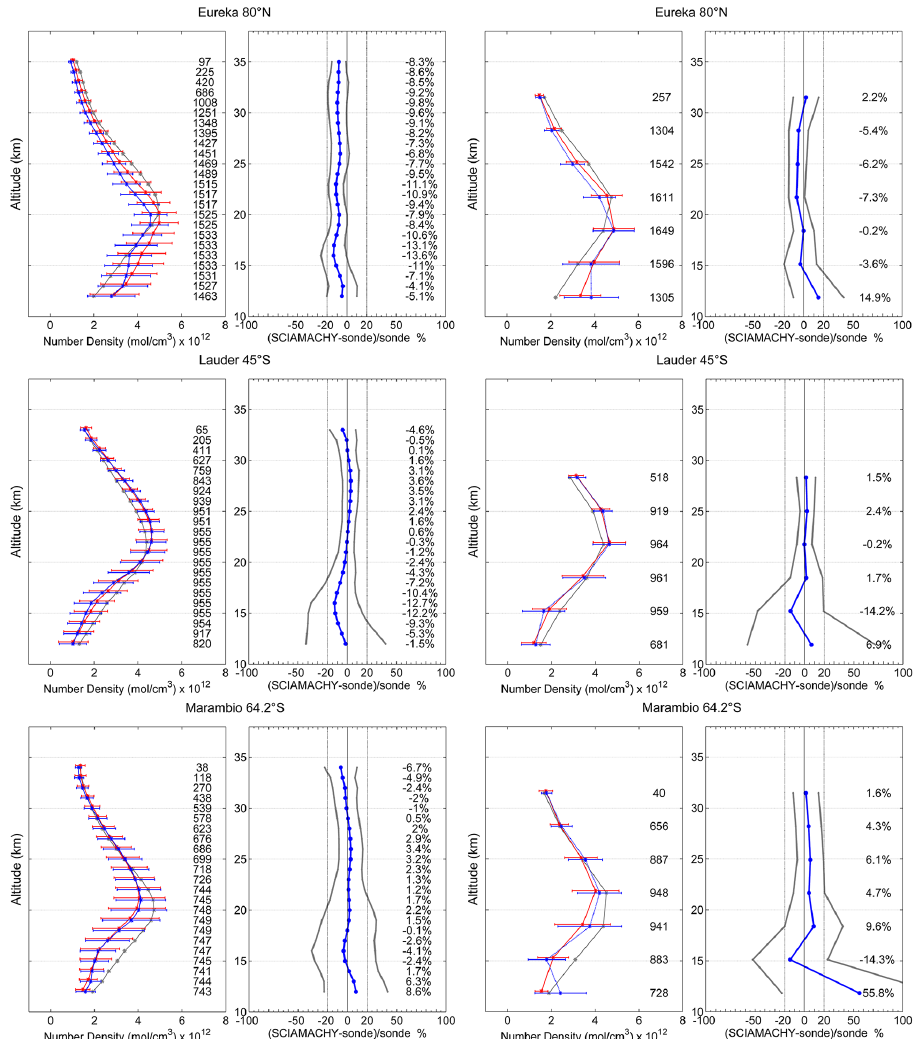
Figure 2. Vertical profile comparisons at Nairobi (1.2 ◦ N, 36.8 ◦ E), Ankara (40.0 ◦ N, 32.8 ◦ E), Praha (50.0 ◦ N, 14.4 ◦ E), Eureka (80.0 ◦ N, 85.9 ◦ W), Lauder (44.9 ◦ S, 169.7 ◦ E) and Marambio (64.2 ◦ S, 56.6 ◦ W) averaged from January 2003 to December 2012. The four panels show the results for the ozone profiles for V2.9 on the left-hand side and for V3.0 on the right-hand side. In the left subpanels, the red and blue curves represent the ozone number densities with 1 σ standard deviations for ozonesonde and SCIAMACHY limb data, respectively. The gray lines show a priori information used in the SCIAMACHY retrieval. In the right subpanels, the blue lines represent the relative mean differences of the ozone concentrations. The gray solid lines depict 1 σ standard deviations. The numbers on the right denote the number of SCIAMACHY limb profiles used in the comparisons and the relative differences for each